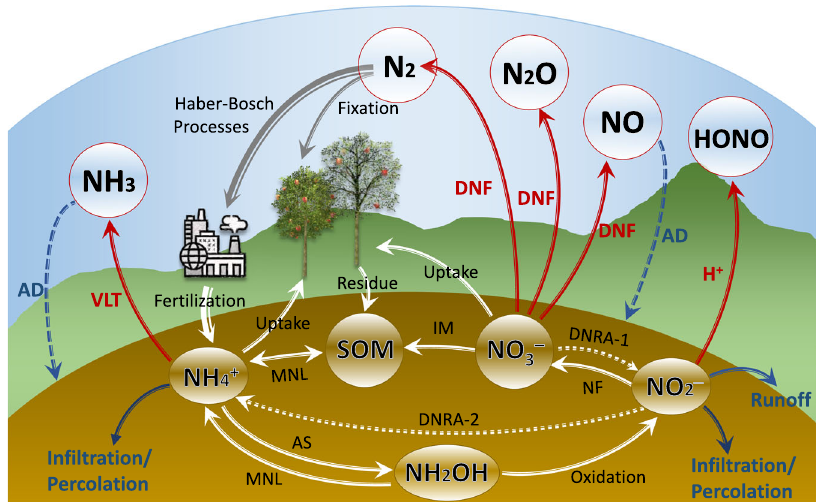
Fig. 1 Mechanisms of nitrogen fertilization in soil systems and the associated nitrogen cycles. VLT Volatilization, DNRA dissimilatory nitrate reduction to ammonia, MNL mineralization, AS assimilation, IM immobilization, NF Nitri fi cation, AD atmospheric